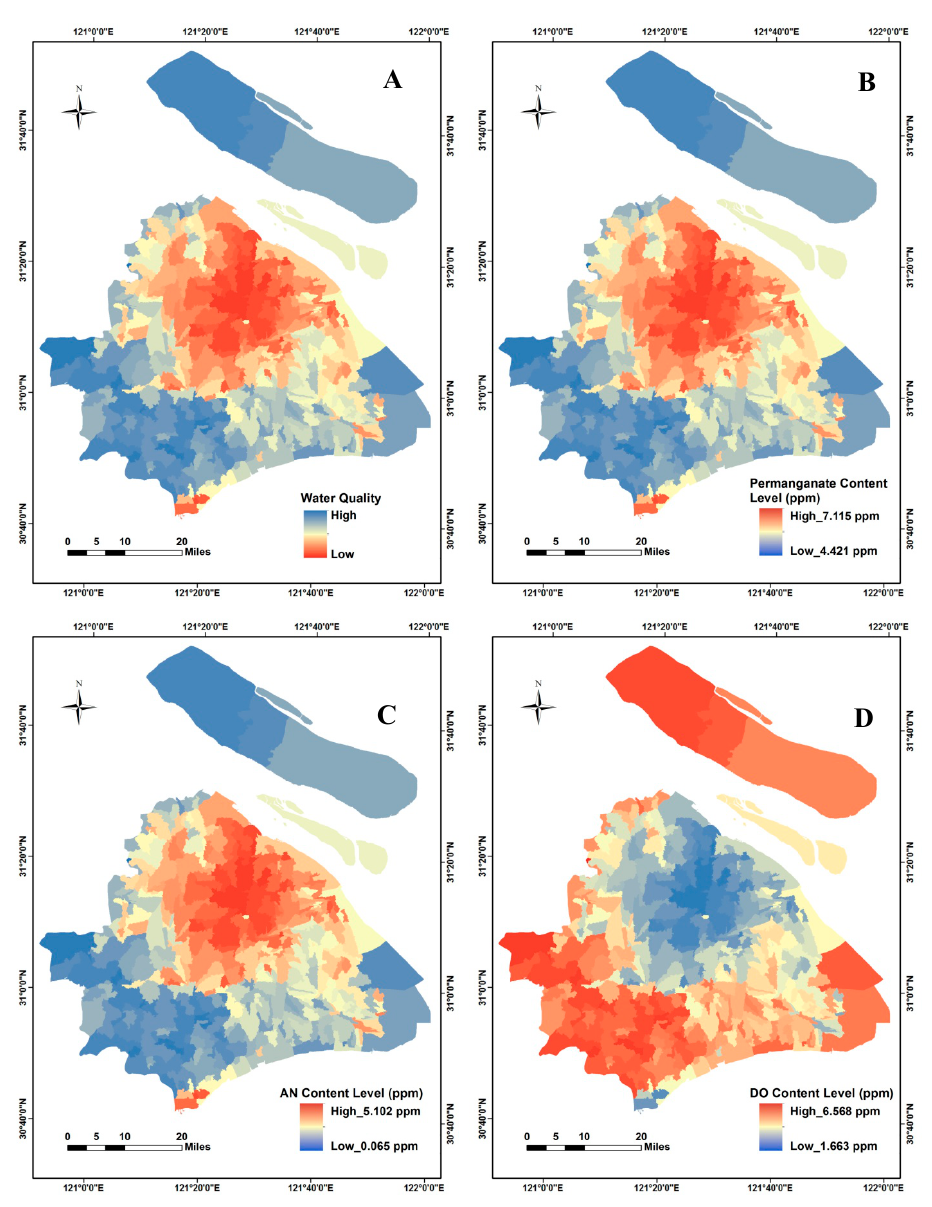
Figure 6. Spatial distributions of the four modeled water quality indicators in 2015: ( A ) GWQ, ( B ) permanganate, ( C ) ammonia nitrogen, and ( D ) DO.